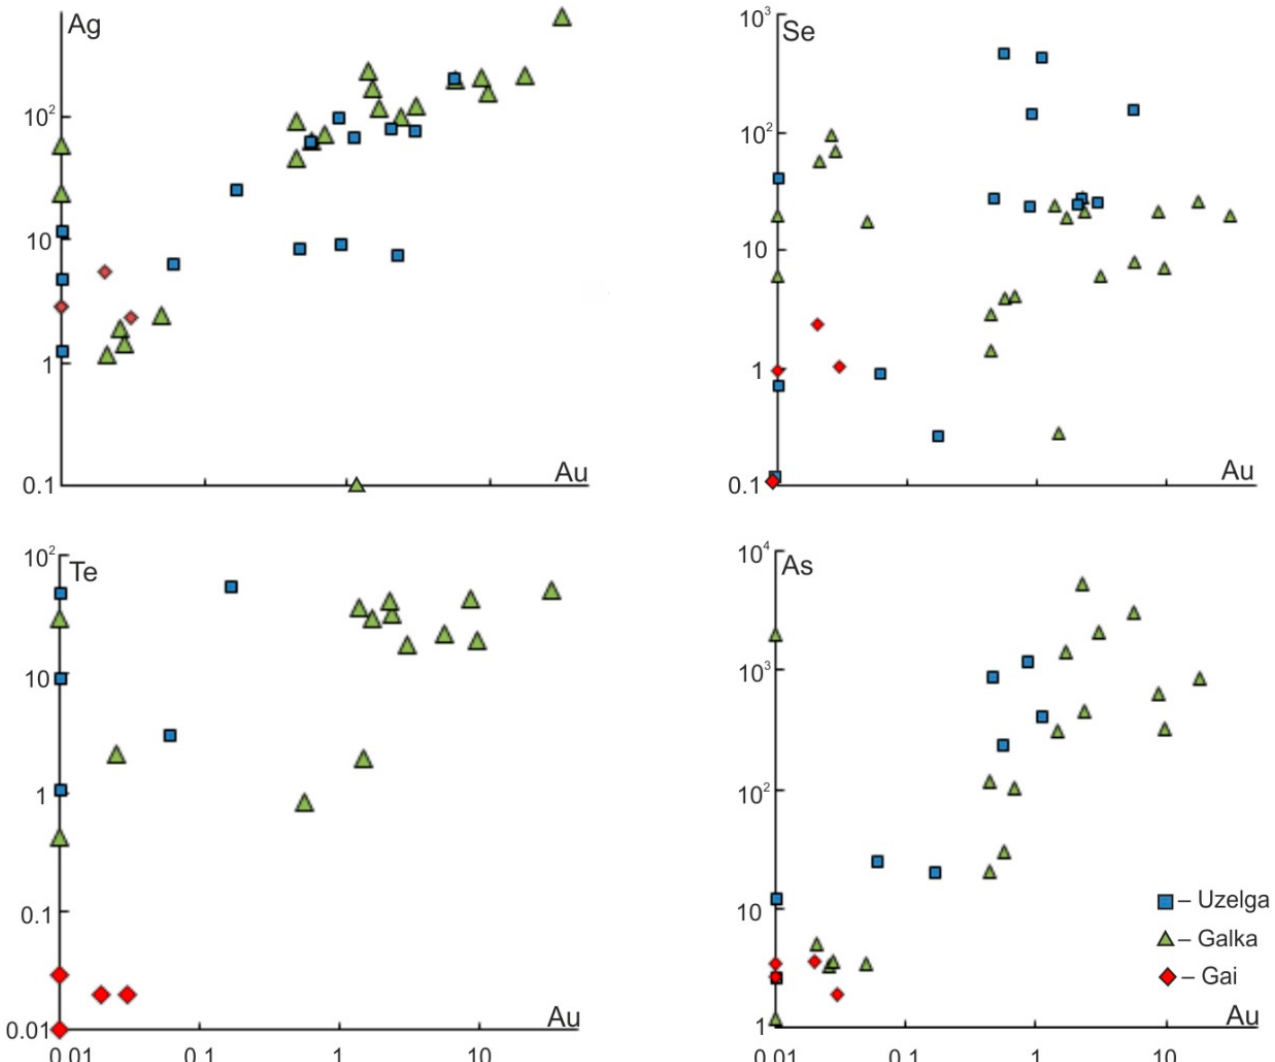
Figure 25. Binary diagrams of the contents of Au, Ag, Se, Te and As (ppm) in sphalerite of the VMS deposits of the Urals according to the LA-ICPMS data.